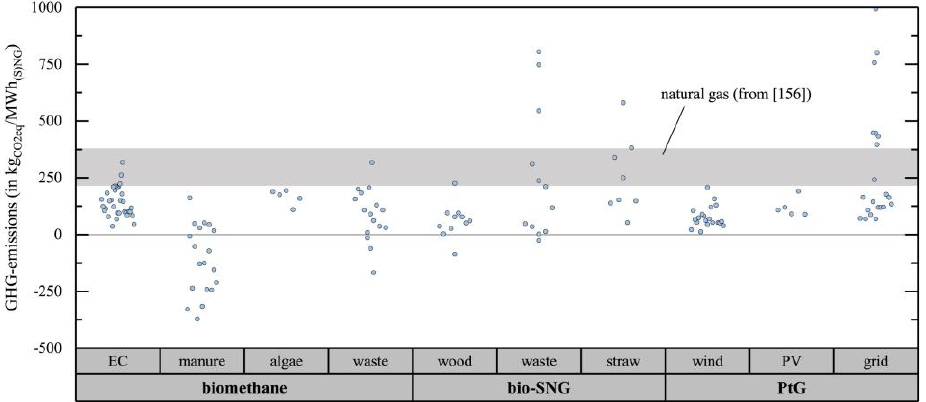
Figure 6. Graphical comparison of the greenhouse gas (GHG) emissions of biomethane from anaerobic digestion and bio − SNG with different feedstock and Power − to − Gas with different electricity sources. The grey area indicates estimates for the CO 2 eq emissions of nature gas from Ref. [52]. All values refer to a time horizon of 100 years and are indicated in kg of CO 2 eq per MWh of SNG (resp. nature gas). EC = energy crops; SNG = Synthetic Natural Gas; PtG = Power − to − Gas. Reprinted from [3].